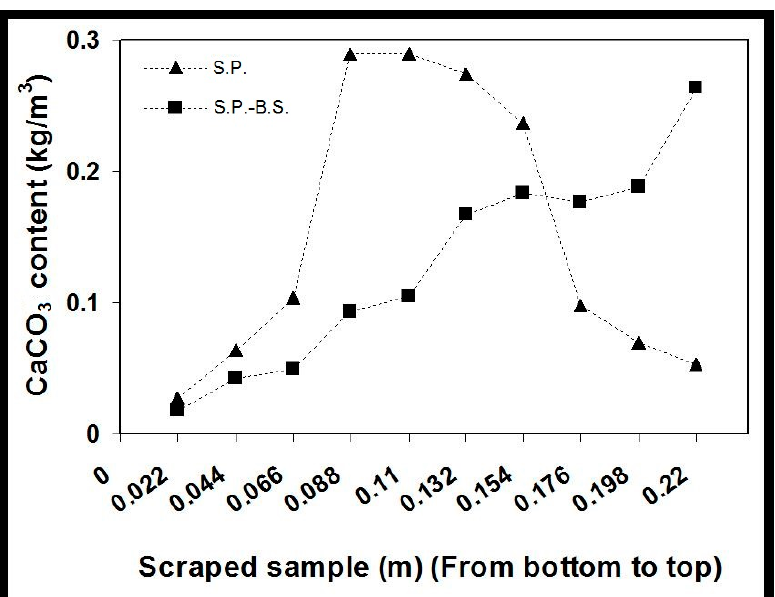
Figure 4. Calcium carbonate profiles along the column length from bottom to top.